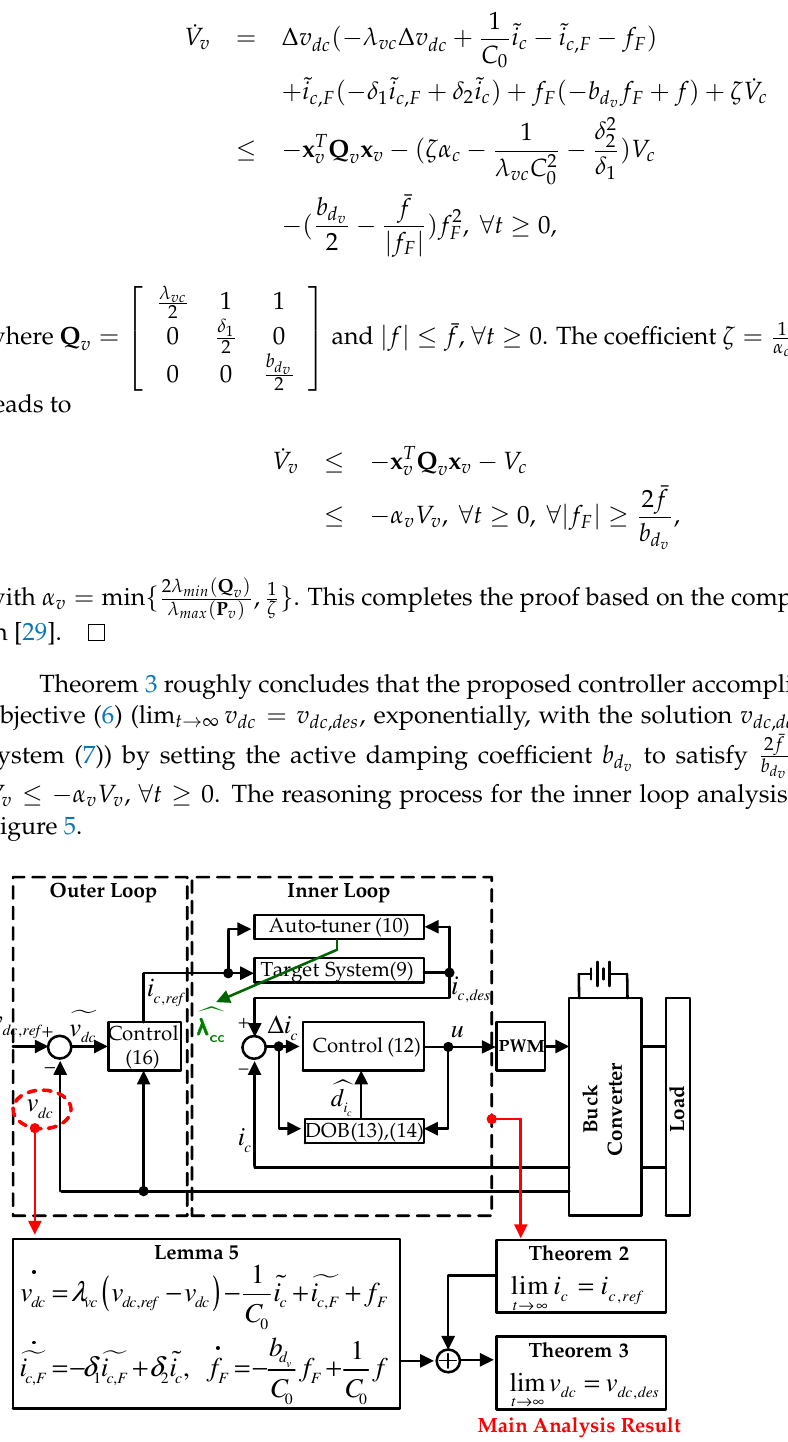
Figure 5. Result of entire loop